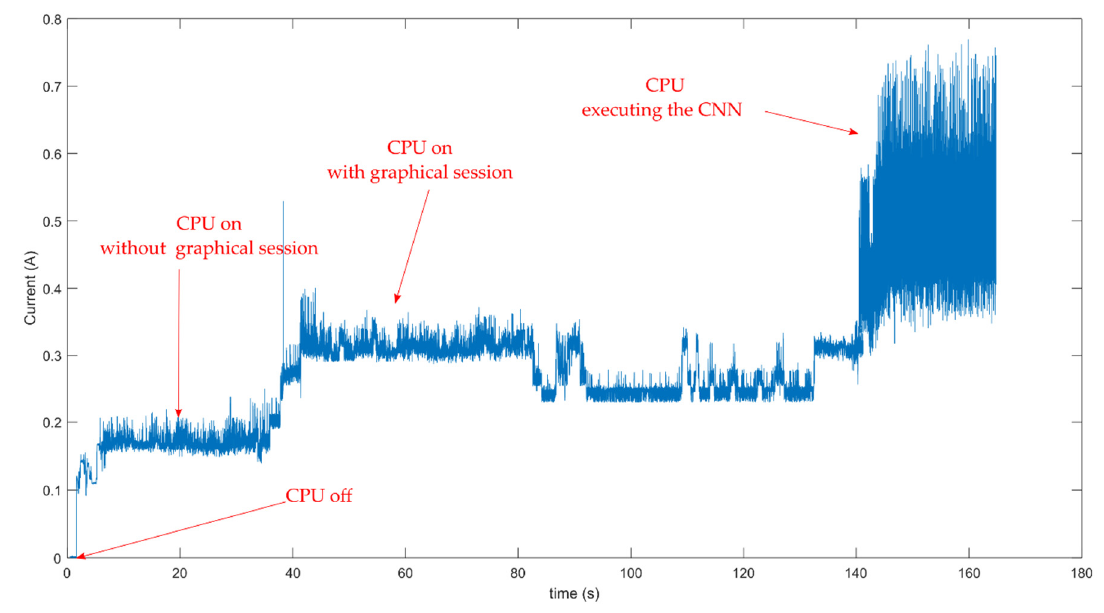
Figure 13. Power consumption of the IoT executing the CNN.